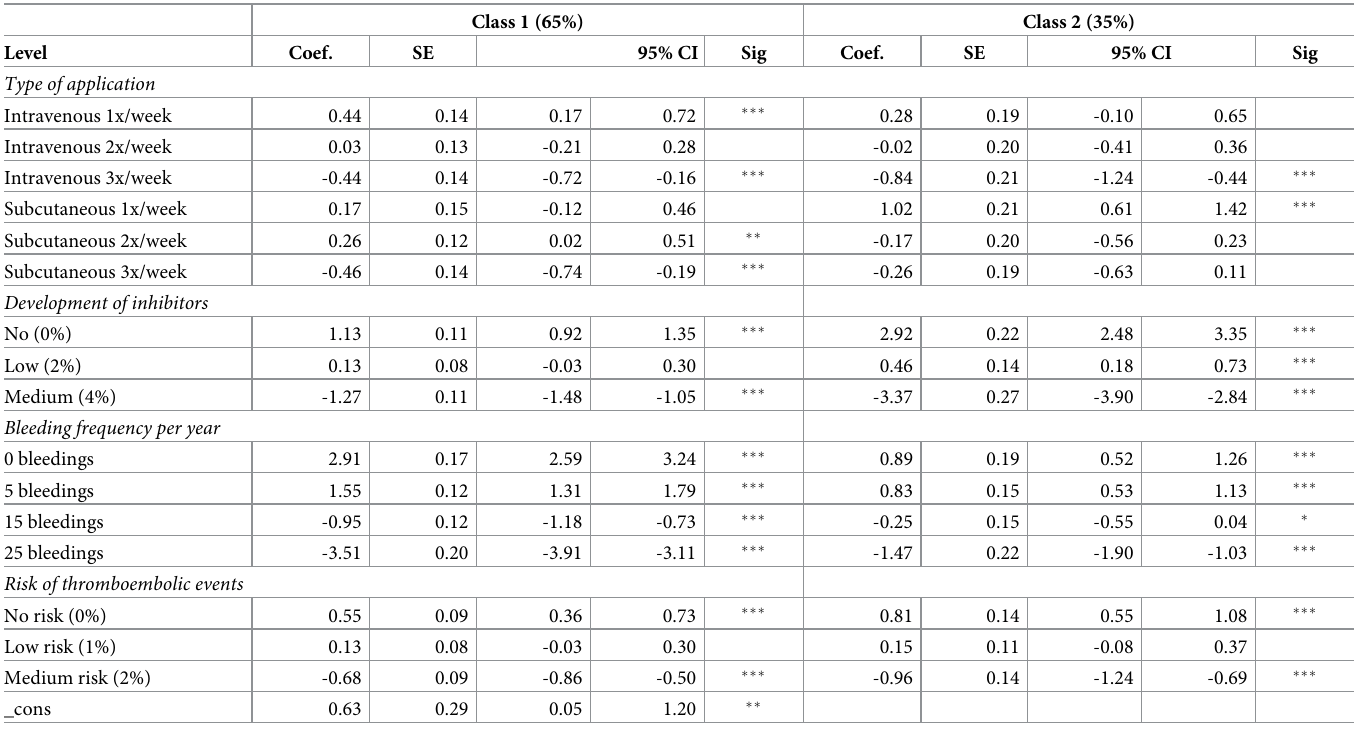
Table 1. Results of the latent class analysis.